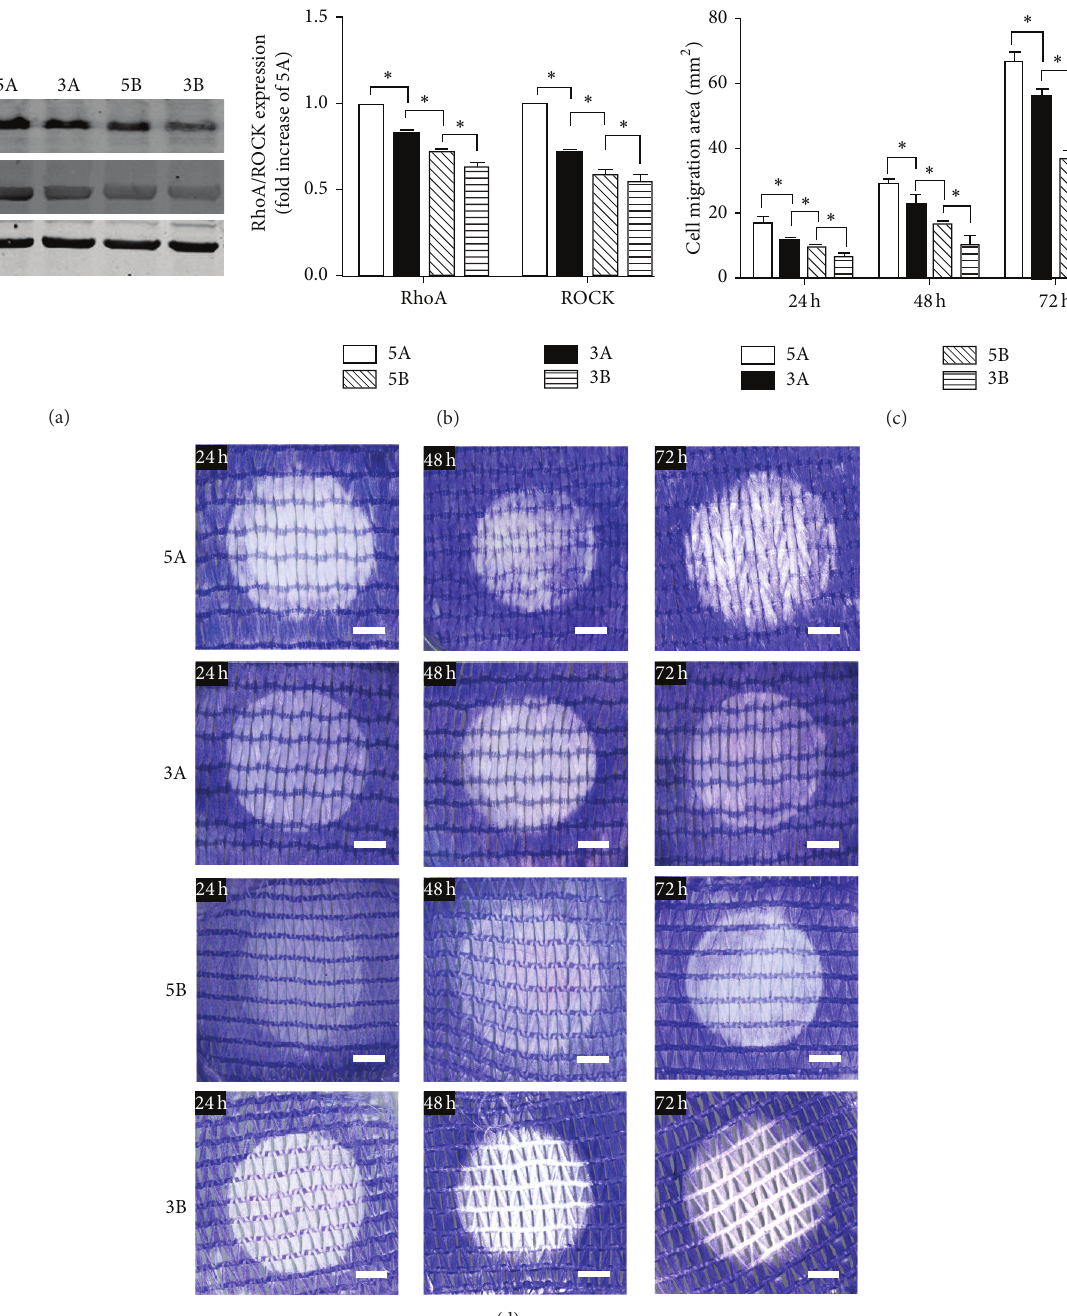
Figure 3: Western blot (a) and semiquantitative analysis (b) of RhoA and ROCK expression in BMSCs on different groups after incubation for 3 days. Stereomicroscope images (d) of Giemsa staining of different groups and histogram of cell migration area (c) which was analyzed from the stereomicroscope images. ∗ indicates 𝑝 < 0.05 . Scale bars: 2mm